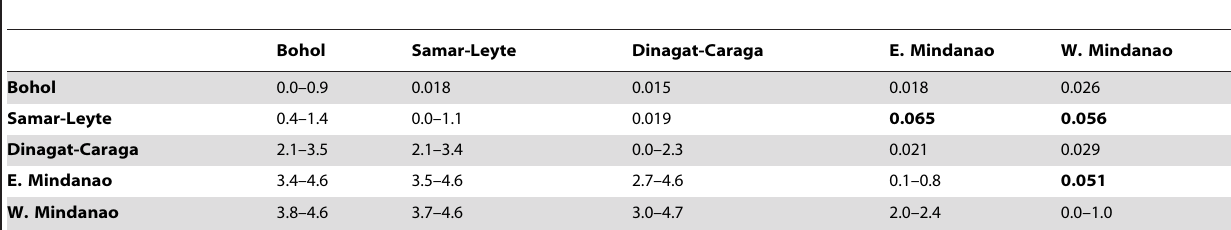
Table 4. Uncorrected mitochondrial sequence divergence (%) among Philippine tarsier ( Tarsius syrichta ) evolutionary lineages shown below